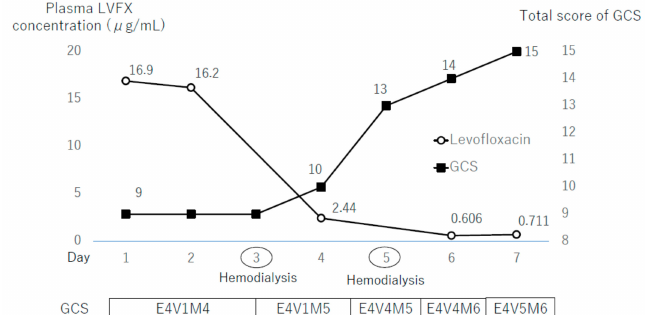
Figure 1. The patient’s clinical course. Hemodialysis was conducted three and five days after hospital admission. LVFX: Levofloxacin; GCS: Glasgow Coma Scale; E: Eye opening; V: Best verbal response; M: Best motor